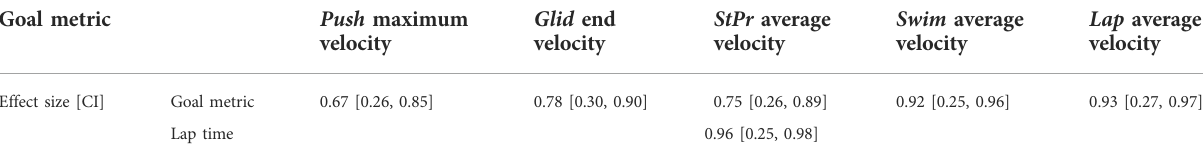
TABLE 2 Effect size and con fi dence interval of all goal metrics and lap time for the comparisons with both meaningful progress and signi fi cant goal metric change. Goal